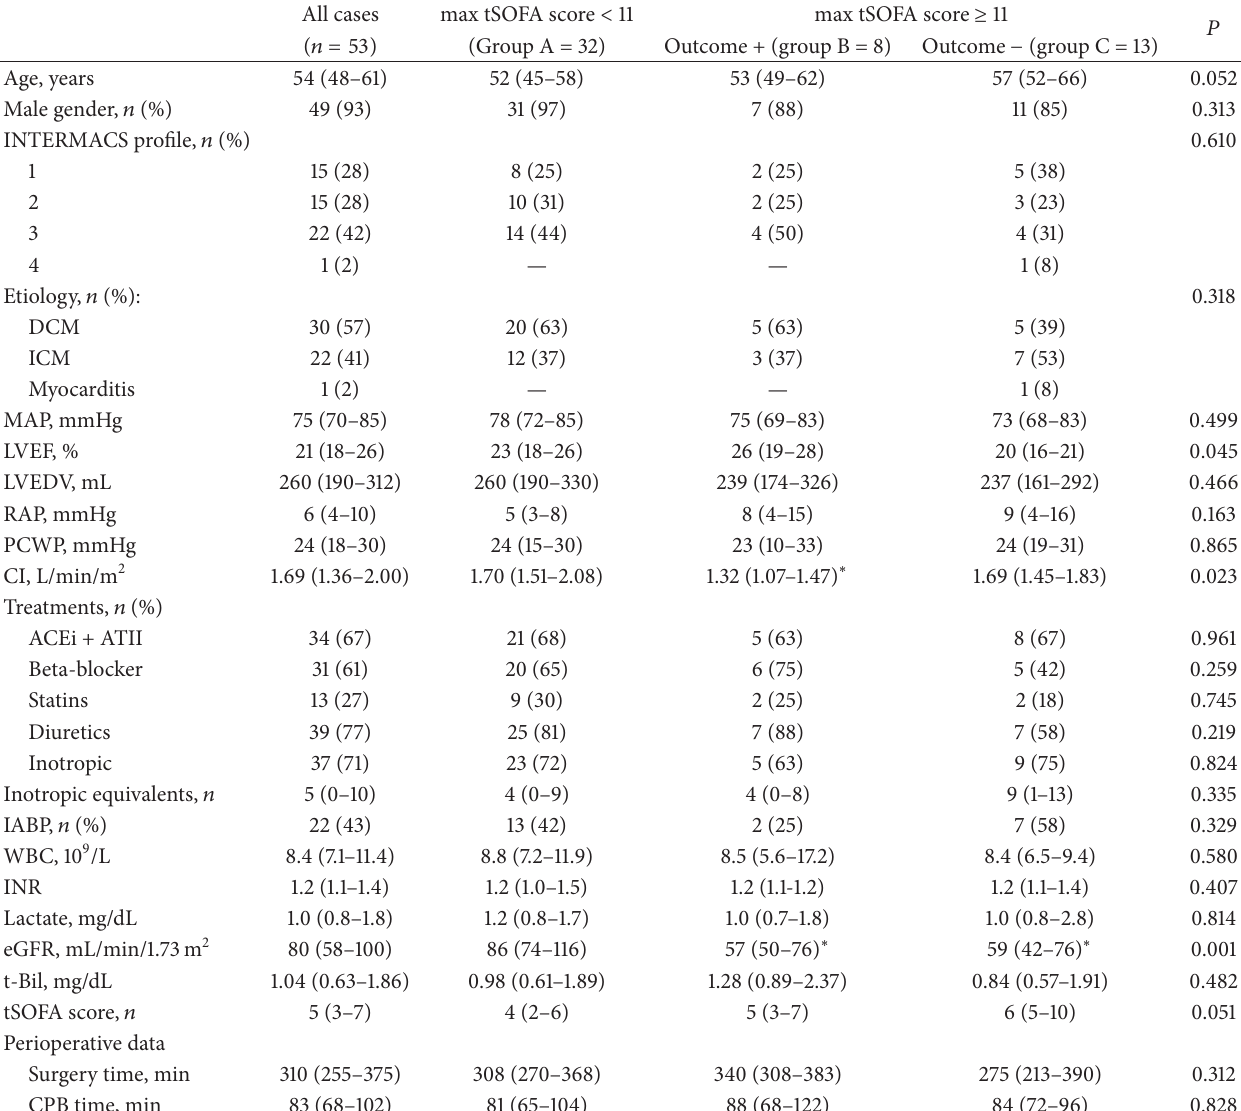
Table 1: Clinical characteristics of patients and perioperative